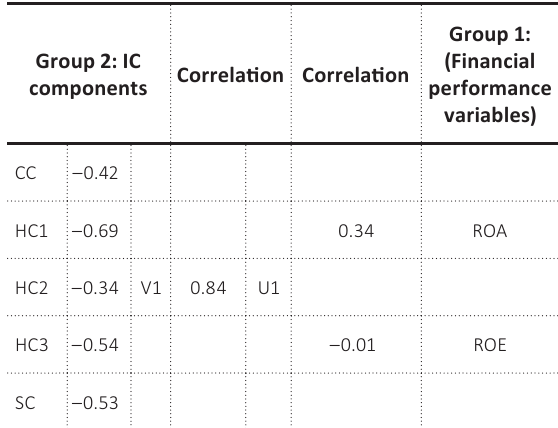
Table 8. The CCA for the service sector